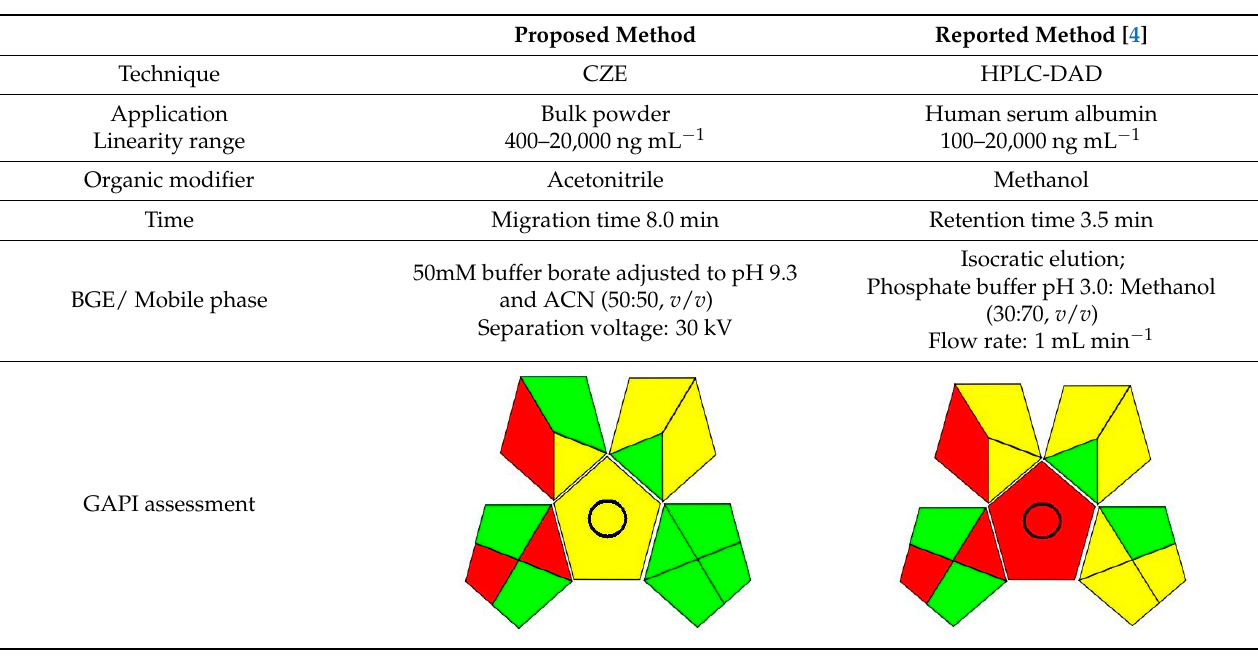
Table 3. Comparison of the proposed CZE analytical method to previously reported HPLC-DAD method.